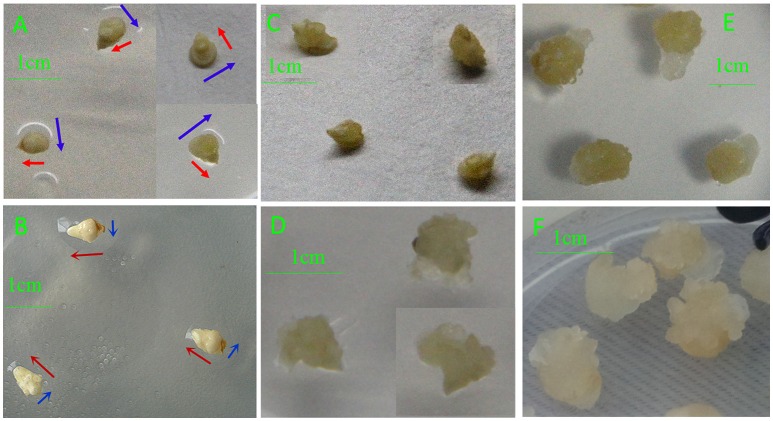
Phenotypic differences in developing callus derived from immature and mature embryos under in-vitro culture conditions. (A) IME3; (B) ME3; (C) IME6; (D) ME6; (E) IME15; (F) ME15. IME3, IME6, and IME15 are immature embryos at 3, 6, and 15 d of culture, respectively. ME3, ME6, and ME15 are mature embryos at 3, 6, and 15 d of culture, respectively. Blue arrows: development in horizontal direction; Red arrows: development in vertical direction.